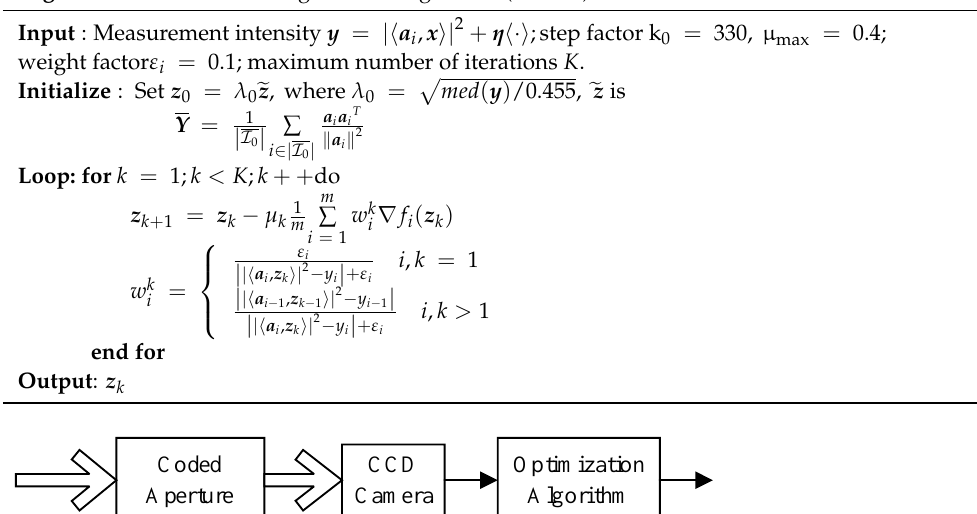
Algorithm 1: Median Reweighted WF algorithm (MRWF)